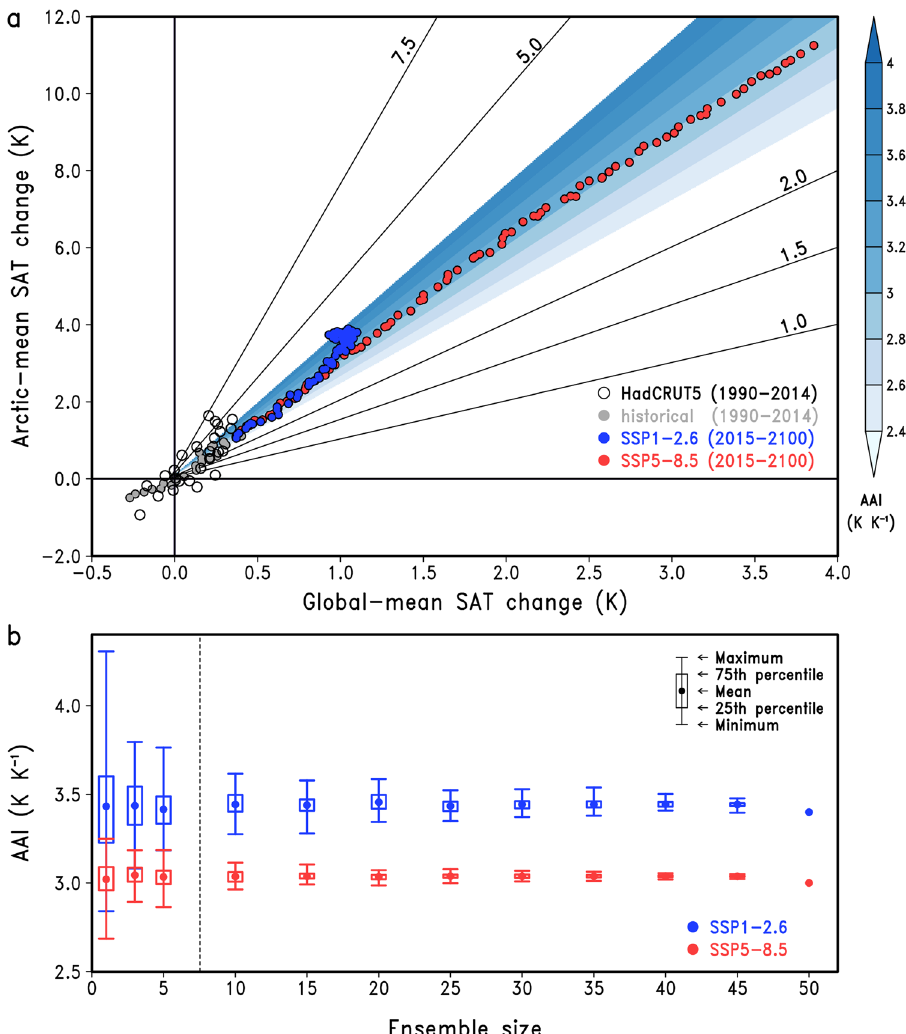
Fig. 1 Relationship between global- and Arctic-mean SAT changes from 1990 to 2100. a Scatter plots of the Arctic-mean (northward of 65 o N) SAT change (K) against the global-mean SAT change (K) from observation (HadCRUT5 (ref. 41 ); black) and the MIROC6 large-ensemble (historical; gray, SSP1- 2.6; blue, SSP5-8.5; red, each plot indicates the 50-member ensemble mean), relative to 1980 – 2009 mean. Background shading and lines represent AAI (K K − 1 ). b Box-and-whisker plots of AAI averaged over 2015 – 2100 in SSP1-2.6 (blue) and SSP5-8.5 (red) as a function of ensemble size. The vertical dashed line indicates a threshold beyond which the two ensembles are statistically